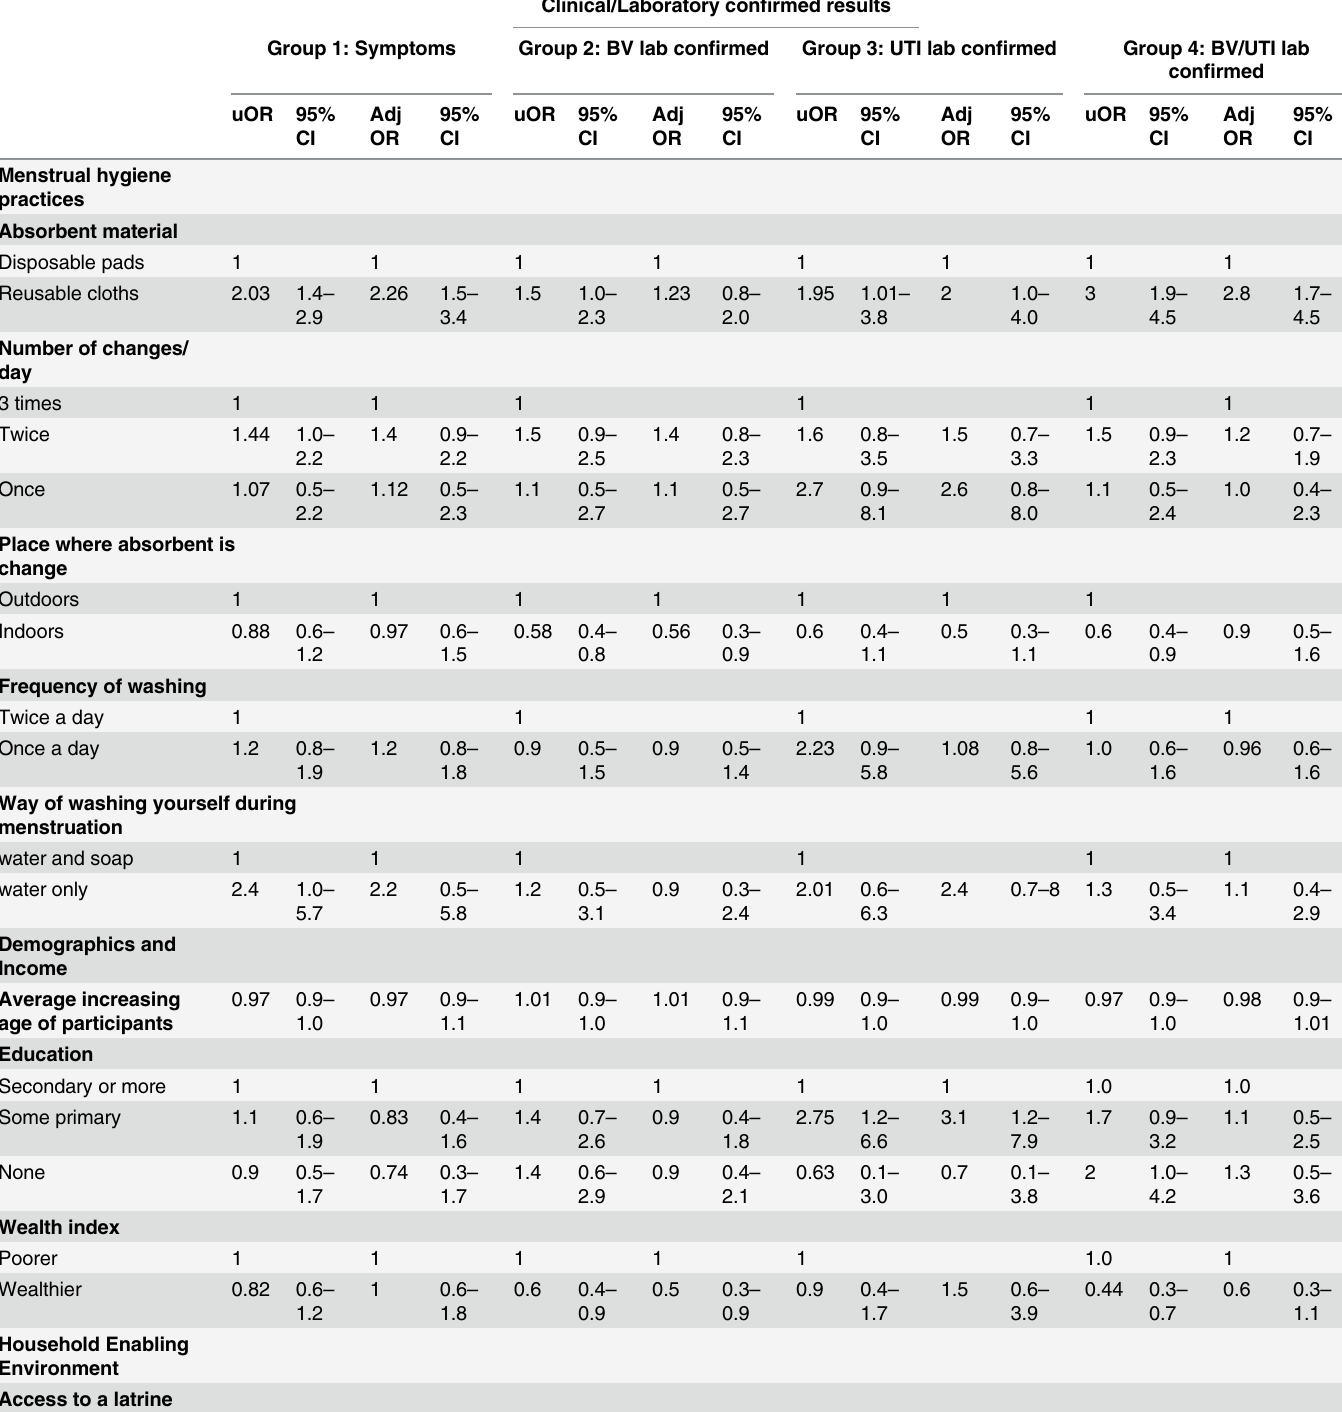
Table 3. Multivariable table with crude and adjusted OR for each model: Group 1: reported symptoms of urogenital disease or inflammation, Group 2: Bacteria vaginosis laboratory definition of cases and controls (BV lab confirmed), Group 3: Urinary tract infections laboratory definition of cases and controls (UTI lab confirmed), Group 4: BV or UTI cases laboratory confirmed and controls laboratory negative for both (excluding symptomatic controls) (BV/UTI lab